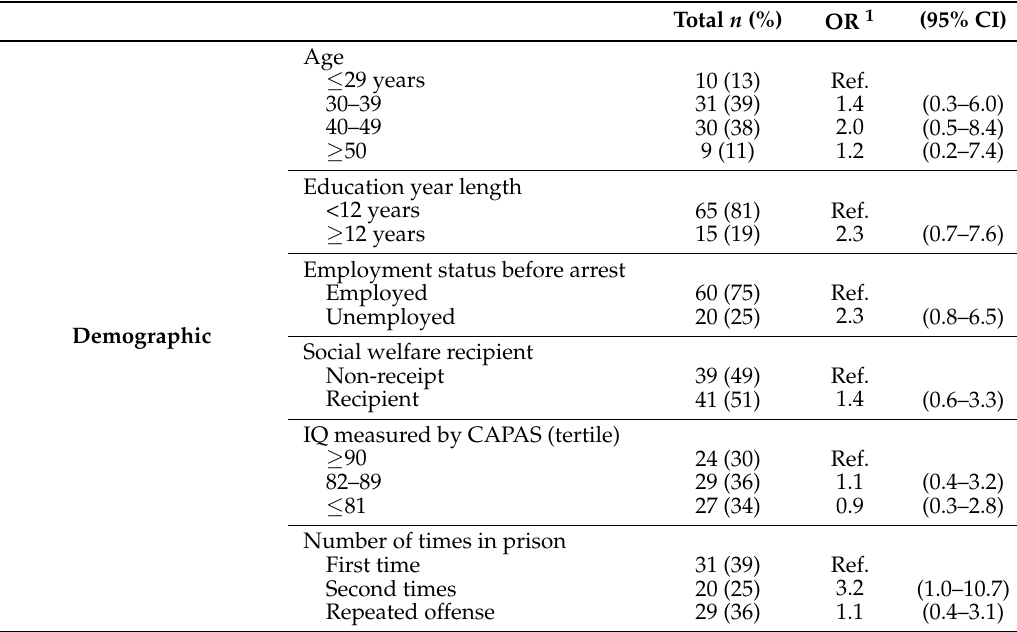
Table 2. Relationship between each characteristic and a high drug dependence problem awareness ( n =